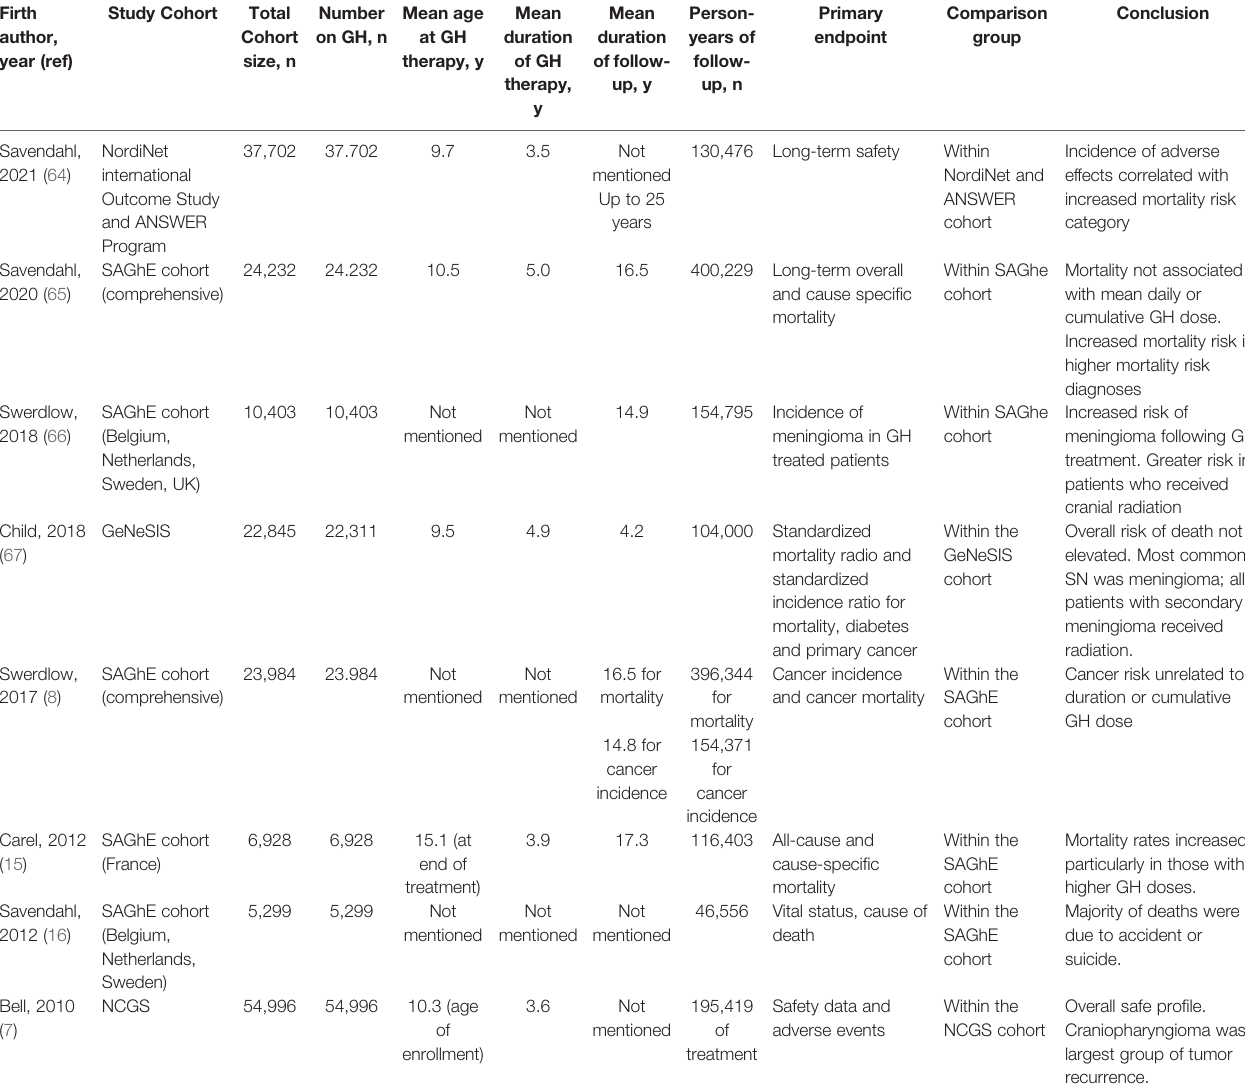
TABLE 3 | Post-marketing or large observational cohort